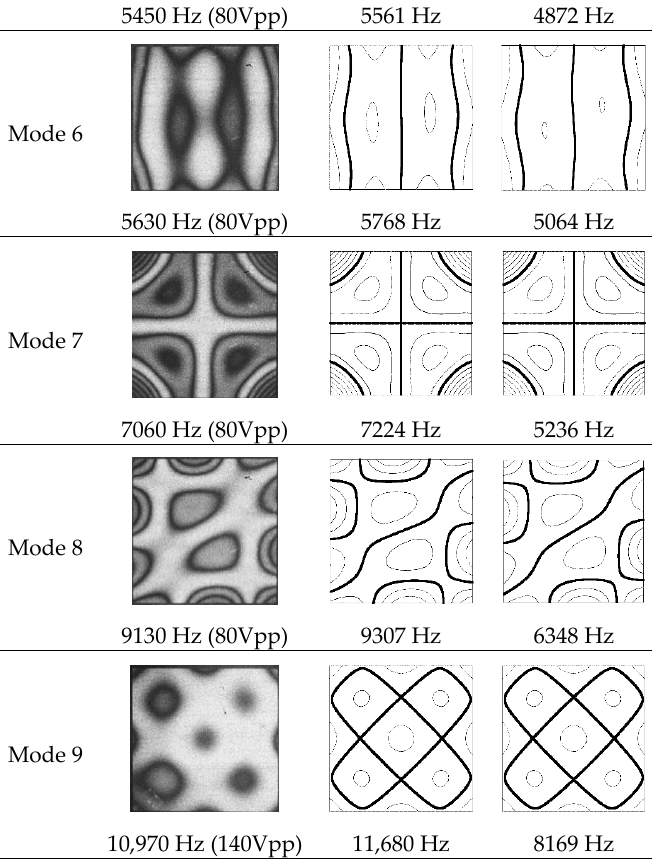
Figure 4. Out-of-plane vibration modes for APC-855.